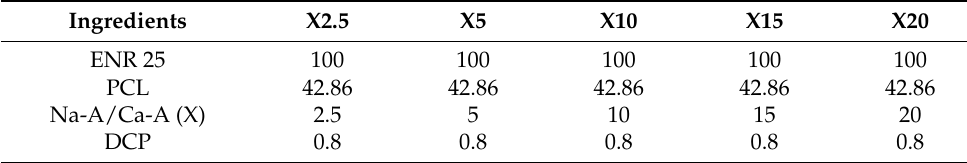
Table 3. Rubber recipes of TPEs reinforced with Na-A and Ca-A 1